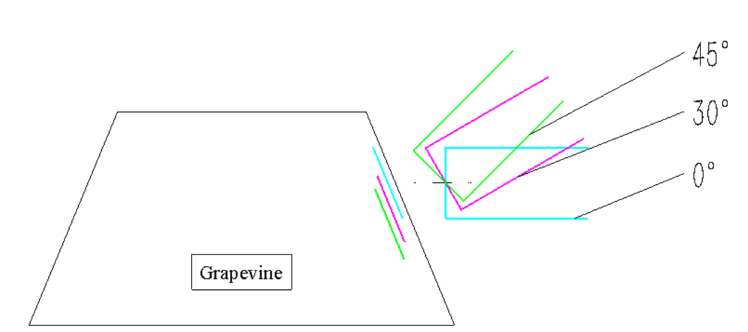
Figure 13. Schematic diagram of air outlet angle.